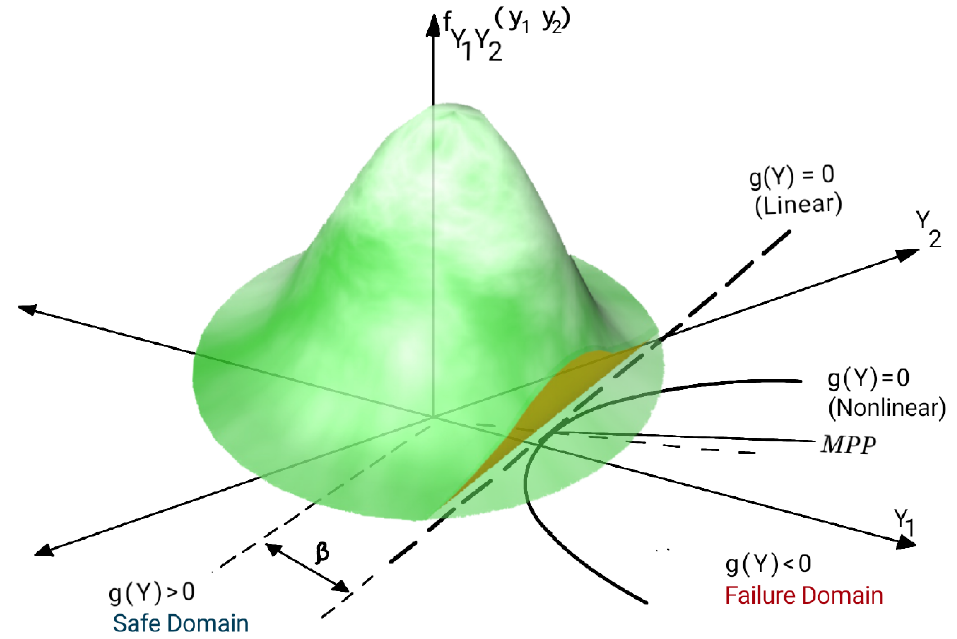
Figure 3. Illustration of the First-Order Reliability Methods (FORM) approximation. See [18] for more details. Adapted with permission from [18]. Copyright 2020, Elsevier.